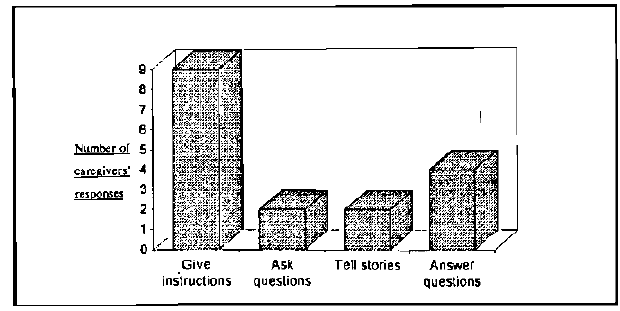
Figure 1. Content of caregiver-child